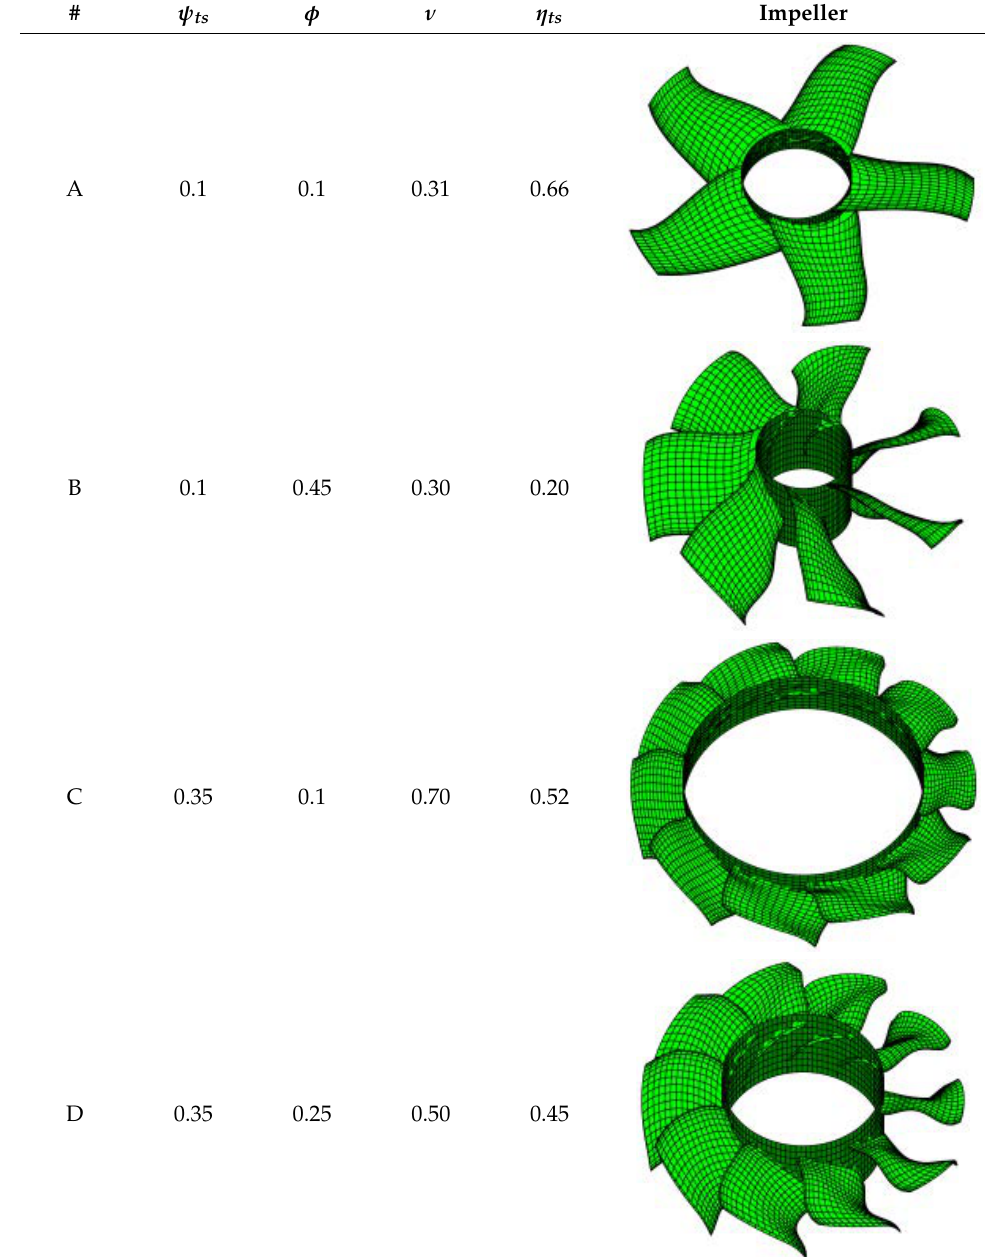
Table 3. Results (selected